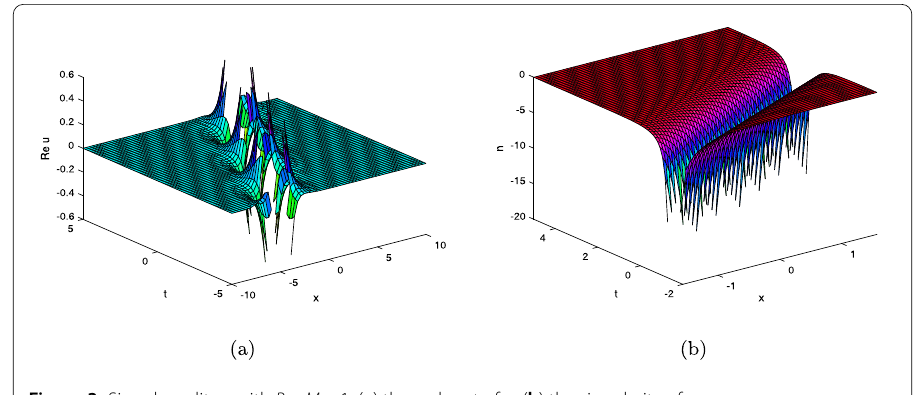
Figure 3 Singular soliton with B = M = 1: ( a ) the real part of u ; ( b ) the singularity of n